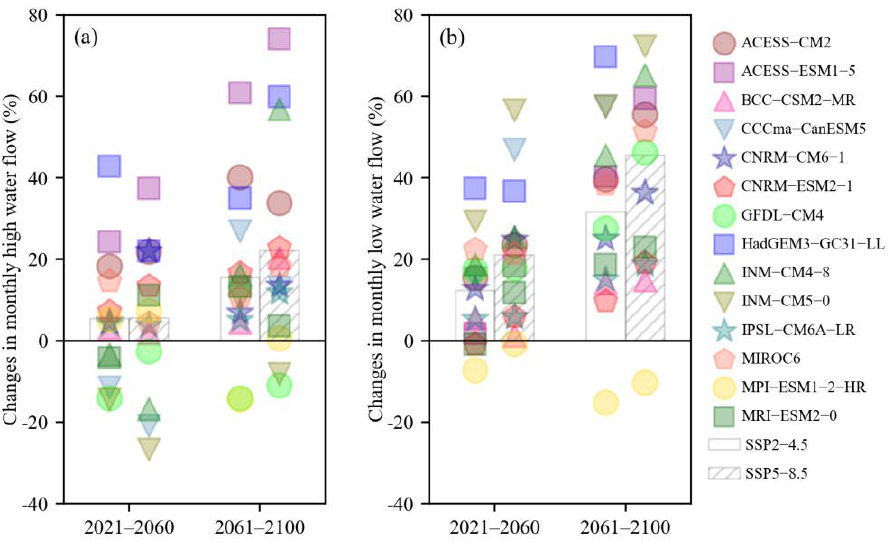
Figure 7. Simulated changes in ( a ) monthly high flow (Q05) and ( b ) monthly low flow (Q95) in the Fujiang River basin for 2021 – 2060 and 2061 – 2100 under 14 GMCs and 2 SSP-RCPs (relative to 1971 – 2010).